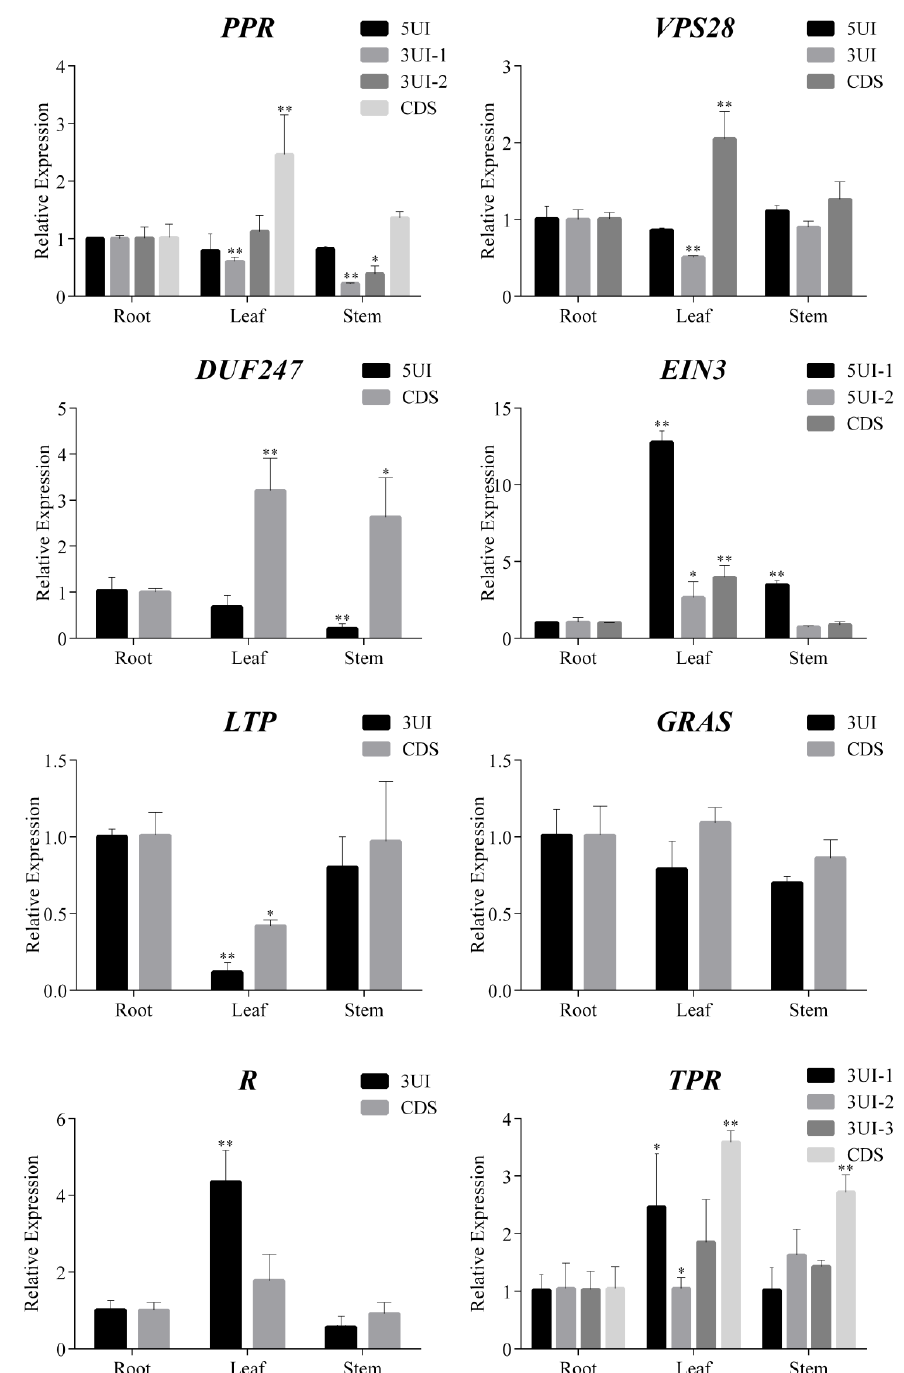
Figure 5. Relative expression results of genes and their UTR introns (UIs) in Citrus sinensis root, leaf and stem. * and ** respectively represent significant di ff erence ( p < 0.05) and very significant di ff erence ( p < 0.01) compared with root. 5UI: intron in the 5 (cid:48) UTR; 3UI: intron in the 3 (cid:48) UTR; CDS: coding sequence; represent the relative expression levels of genes containing these structures. PPR : Pentatricopeptide repeat superfamily protein (Cs6g01290.1), VPS28 : Vacuolar protein sorting-associated 28 (Cs2g06750.1), EIN3 : Ethylene-insensitive 3 (Cs2g29100.1), DUF247 : domain of unknown function 247 gene (Cs2g24990.1), GRAS : GRAS transcription factors (Cs8g18700.1), TPR: Tetratricopeptide repeat-like superfamily protein (Cs8g15200.1), R : Disease resistance protein (Cs5g21990.1) and LTP : Lipid transfer protein